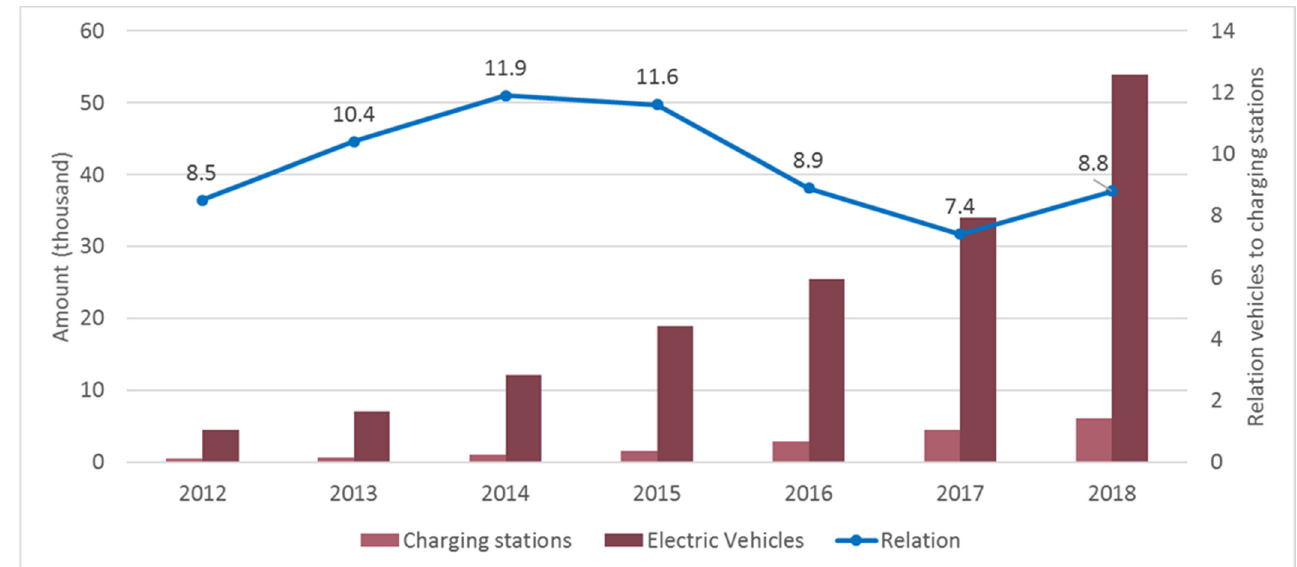
Figure 2. Development of public charging stations.